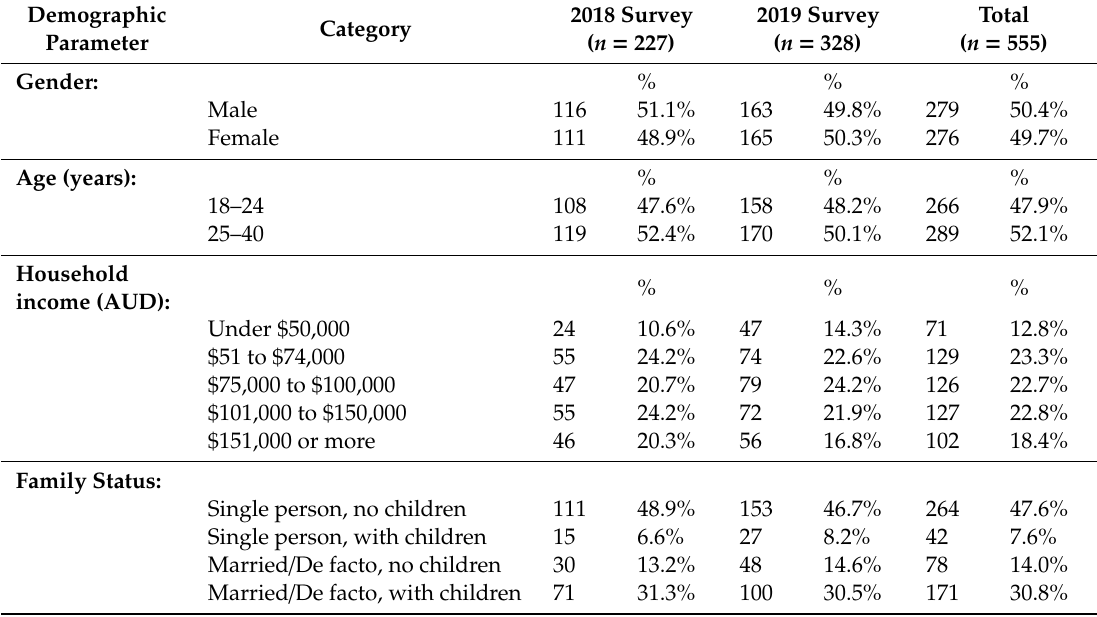
Table 2. Demographic characteristics.